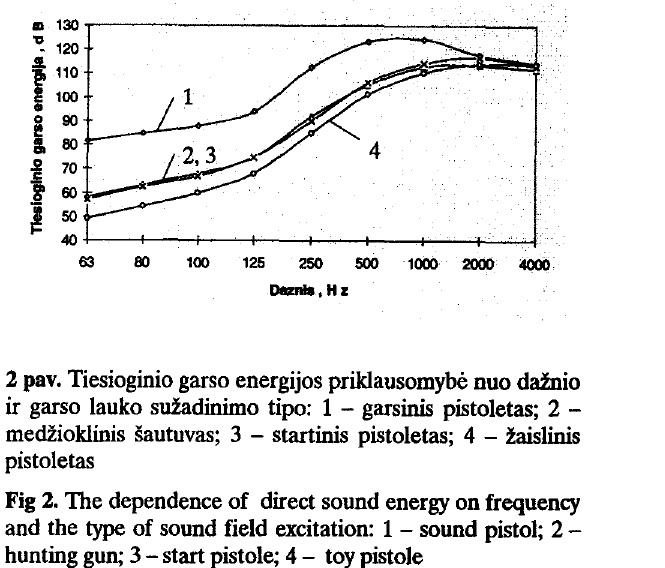
Fig 2. The dependence of direct sound energy on frequency and the type of sound field excitation: 1 - sound pistol; 2